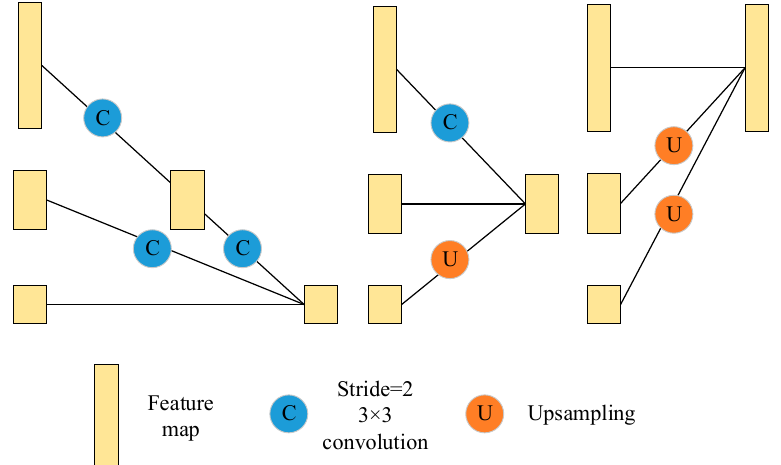
Figure 5. Exchange unit of